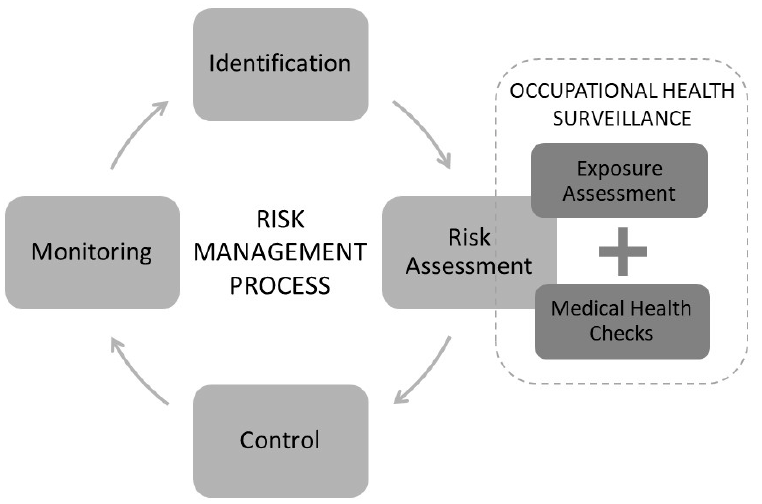
Figure 2. Exposure assessment and medical health checks targeting the current exposure constitute a comprehensive risk assessment in the risk management process.